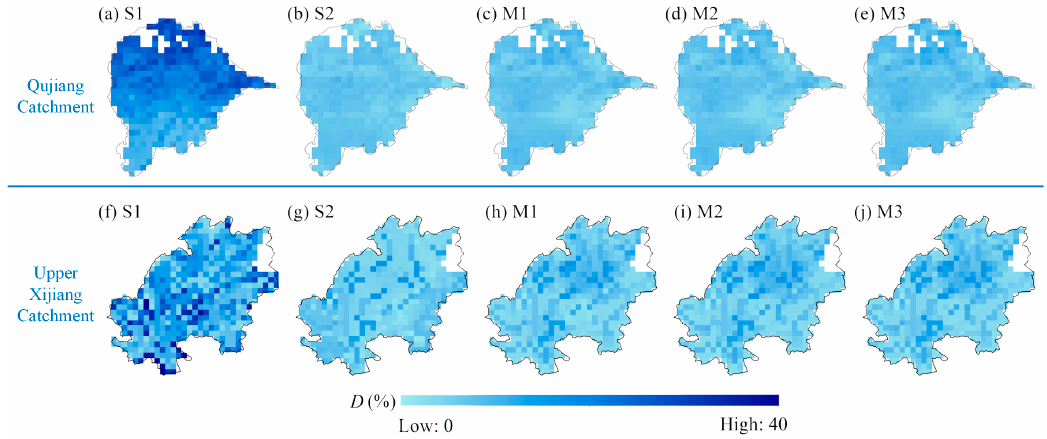
Figure 13. Gridded Average Deviation Amplitude ( D ) for 90% confidence limits of total predictive uncertainty for SM (%) in multiple scenarios (S1–S2, M1–M3) during the validation period in Qujiang catchment ( a – e ) and Upper Xijiang catchment ( f – j